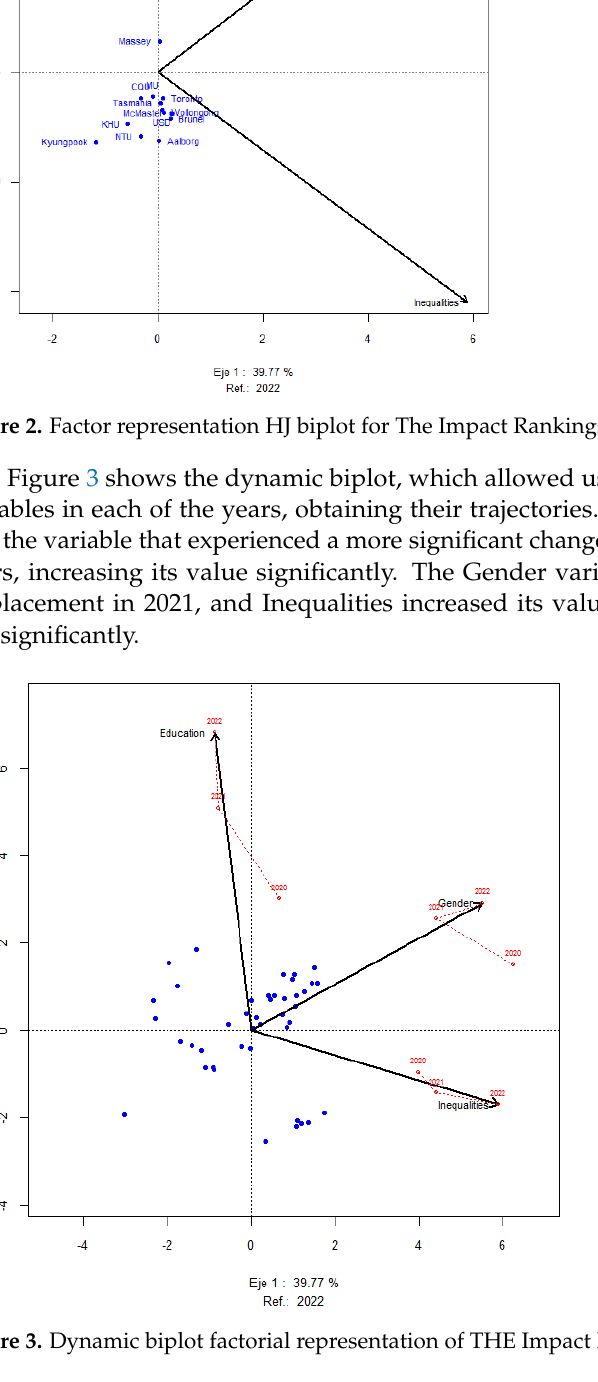
Figure 4. Dynamic biplot factorial representation of THE Impact Rankings (universities), plane 1–2. The points of the figure represent the universities, the names have been omitted because the im ‐ portant thing is to observe their trajectories.